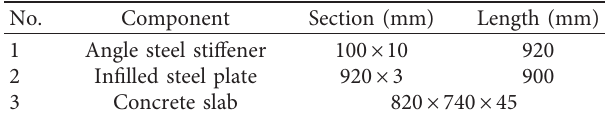
Figure 2: Construction of novel BRSPSW. (a) 3D perspective. (b) Side profile. (c) Infilled steel plate. Table 1: Dimensions of the components in the finite element model.